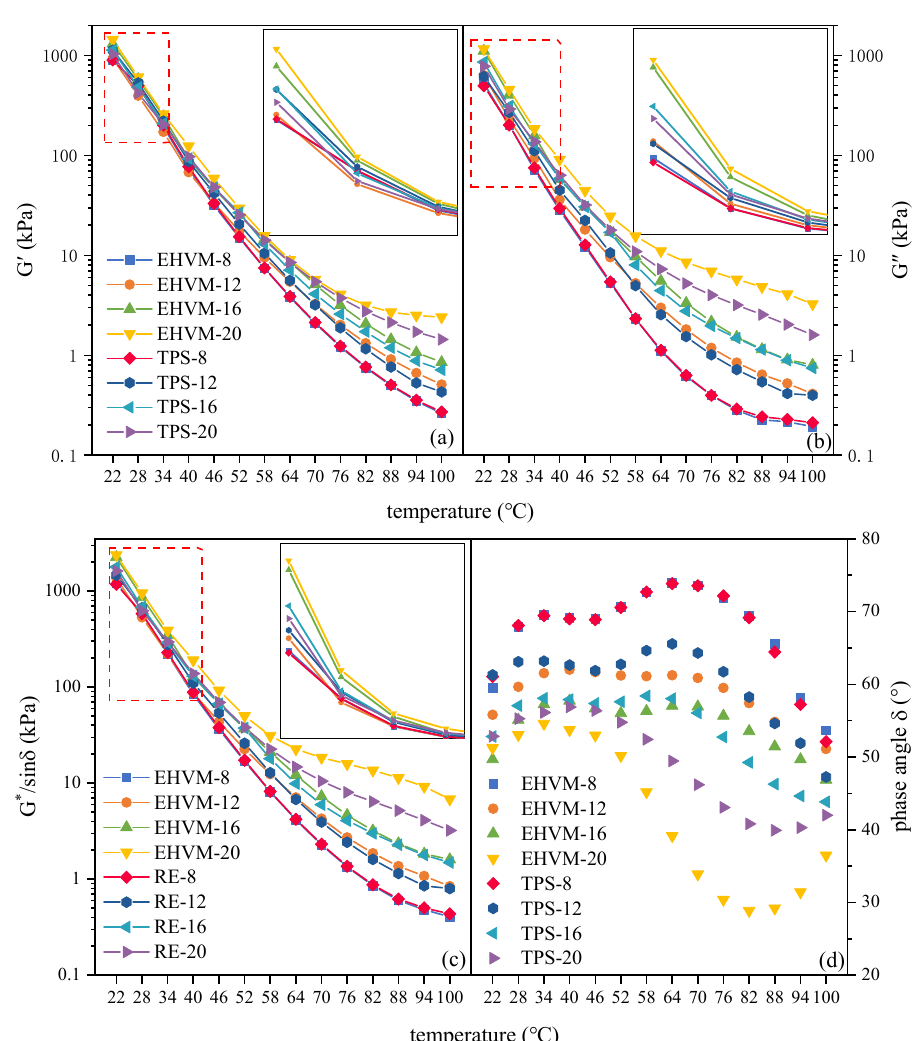
Figure 5. Temperature sweep test results for different HVA: ( a ) storage modulus G′; ( b ) loss modu- lus G′′; ( c ) rutting factor G * /sin δ ; and ( d ) phase angle δ .